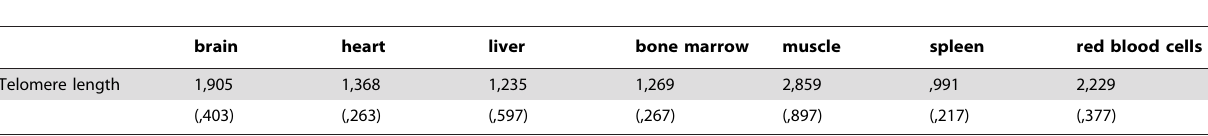
brain heart liver bone marrow muscle spleen red blood cells